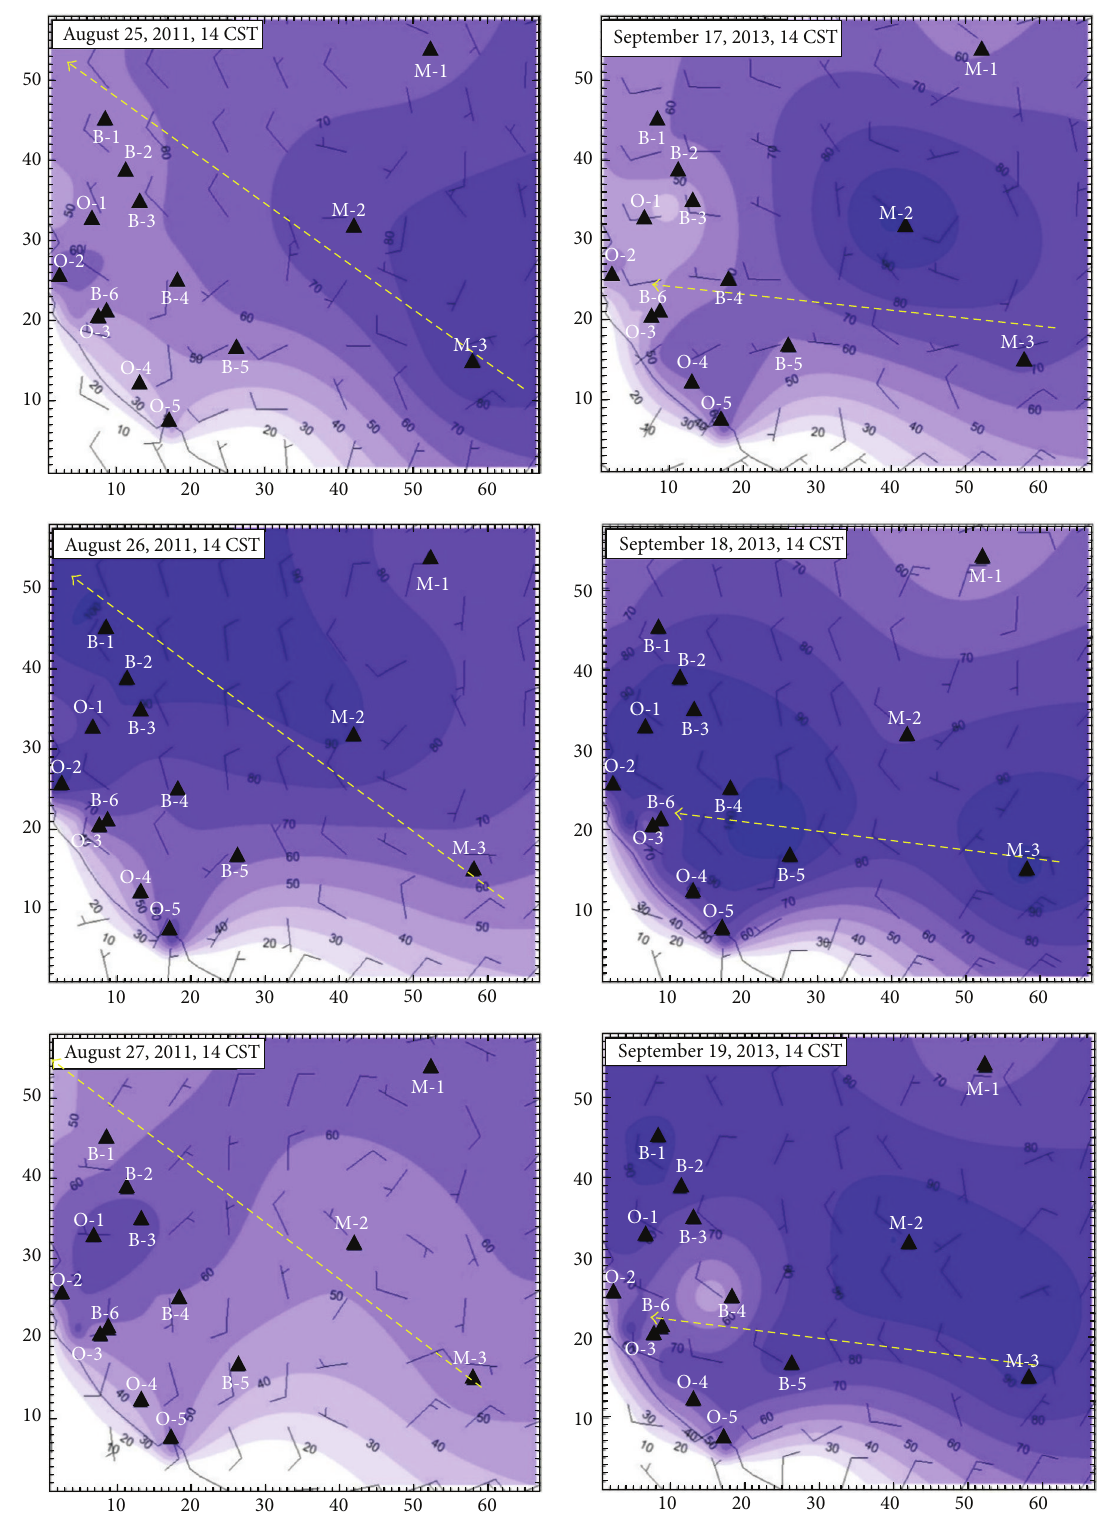
Figure 10: Modeled ozone concentration contours in the ambient air of Southern Taiwan during the invasions of typhoons Nanmadol and